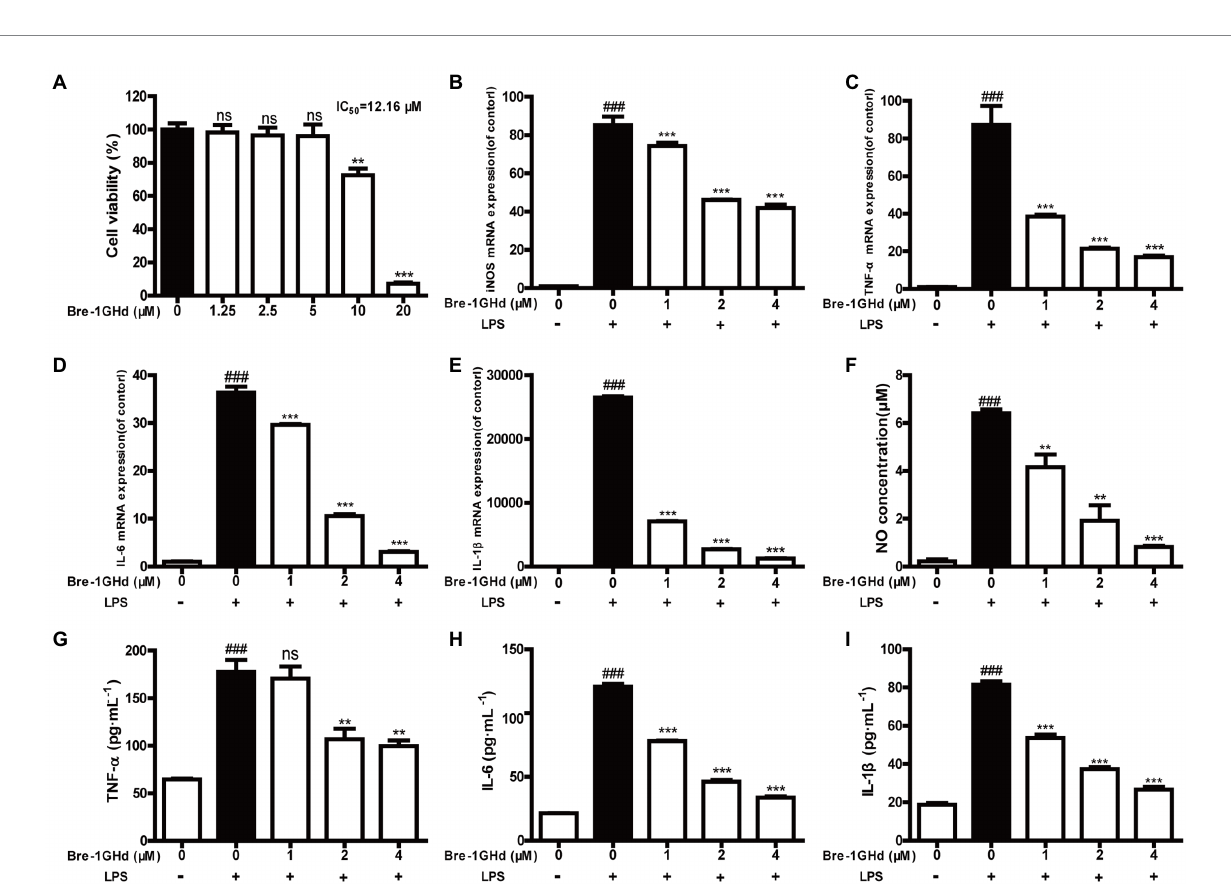
FIGURE 3 Effects of Brevinin-1GHd on the generation of nitrite and cytokines induced by LPS. (A) Proliferation inhibition activity of Brevinin-1GHd on RAW 264.7 cells. The cells were incubated with Brevinin-1GHd (1.25–20 μ M) for 24 h, and then the IC 50 value of Brevinin-1GHd on RAW264.7 cells was determined by CCK-8. (B–I) The effect of Brevinin-1GHd on production of NO, TNF- α , IL-6 and IL-1 β in RAW 264.7 cells recruited with LPS. Data are mean ± SEM ( n = 3). ∗∗ p < 0.01 and ∗∗∗ p < 0.001 as well as ### p < 0.001 indicate significant difference in comparison with the control incubated with 100 ng/ml LPS and the control without LPS plus Brevinin-1GHd, respectively.